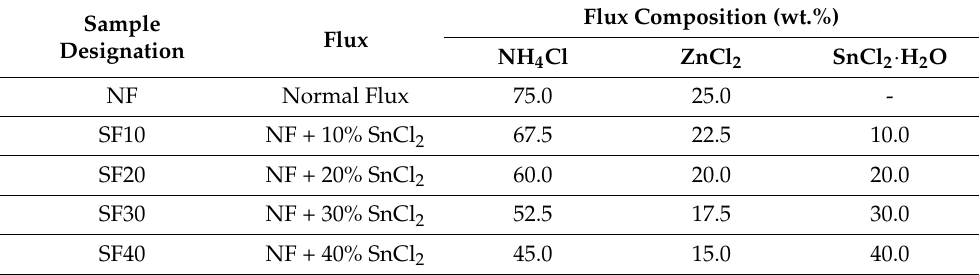
Table 2. Flux compositions and sample